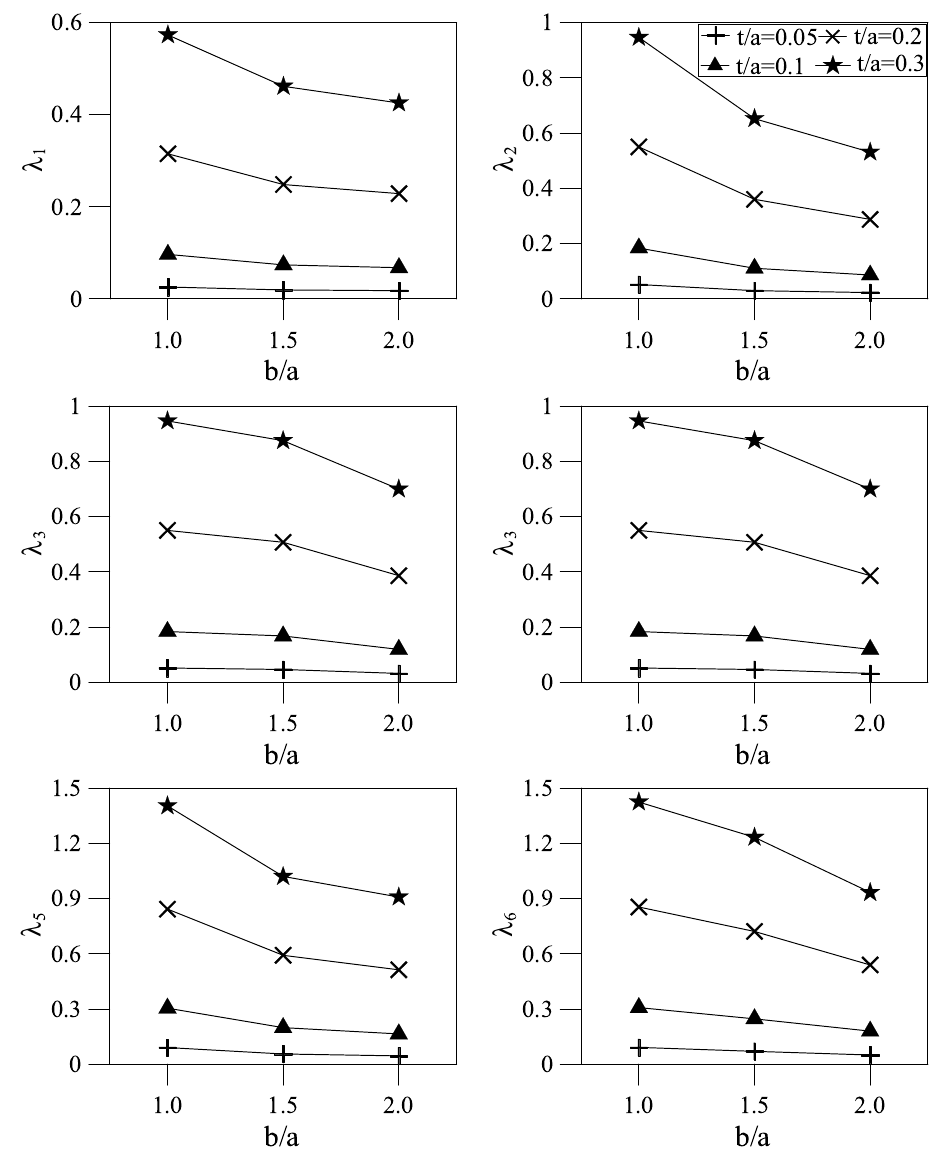
Fig. 5. Effects of aspect ratio and thickness/span ratio on the first six frequency parameters of the thick clamped plates. The increases in the absolute maximum bending moment, M x , increase with increasing aspect and thickness/span ratios. This is understandable that increasing the aspect ratio makes the plate stiffer in the short span, the x axis, direction. As also seen from this figure, in general, the effects of the changes in the aspect ratios on the absolute maximum bending moment, M x , are larger than the changes in the thickness/span